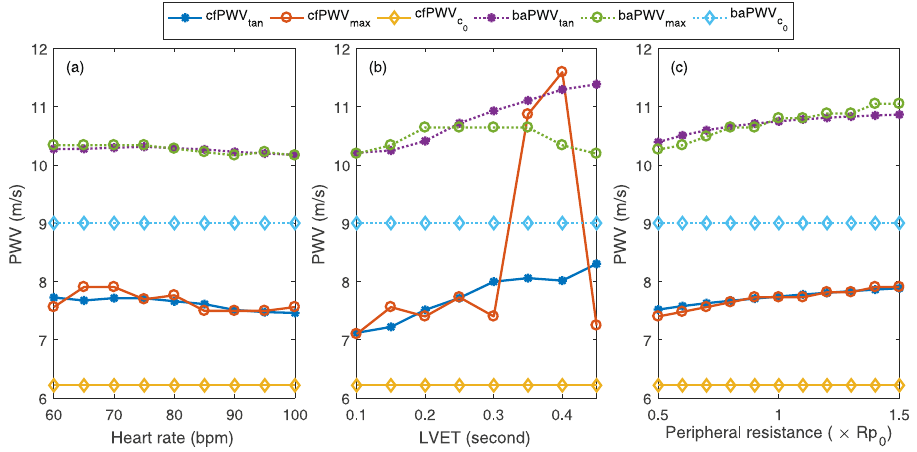
Figure 2. Effects of ( a ) heart rate, ( b ) LVET and ( c ) peripheral resistance on cfPWV and baPWV.